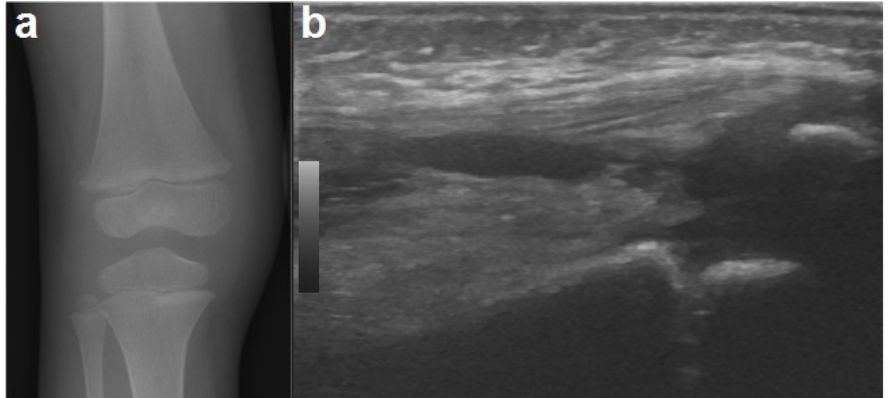
Figure 1. An X-ray of the right knee ( a ) showing periarticular soft tissue swelling without bone involvement. A joint ultrasound of the right knee ( b ) demonstrating a small amount of joint effusion in the suprapatellar recess.